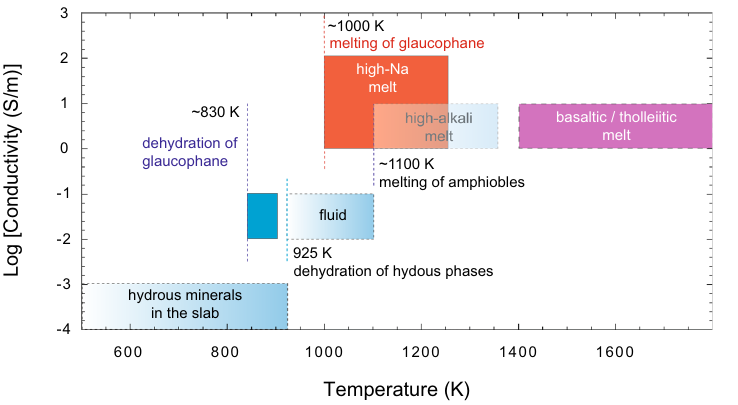
Figure 4. A compilation of electrical properties of hydrous minerals, fluid, and melt in the slab. The comparison of the electrical properties of hydrous minerals and their dehydration product (Manthilake et al. 2021a, 2021b 7,8 and references therein) with glaucophane and its dehydration products. The dehydration and melting temperatures of glaucophane (gln) are lower than those observed for other major hydrous minerals in subduction